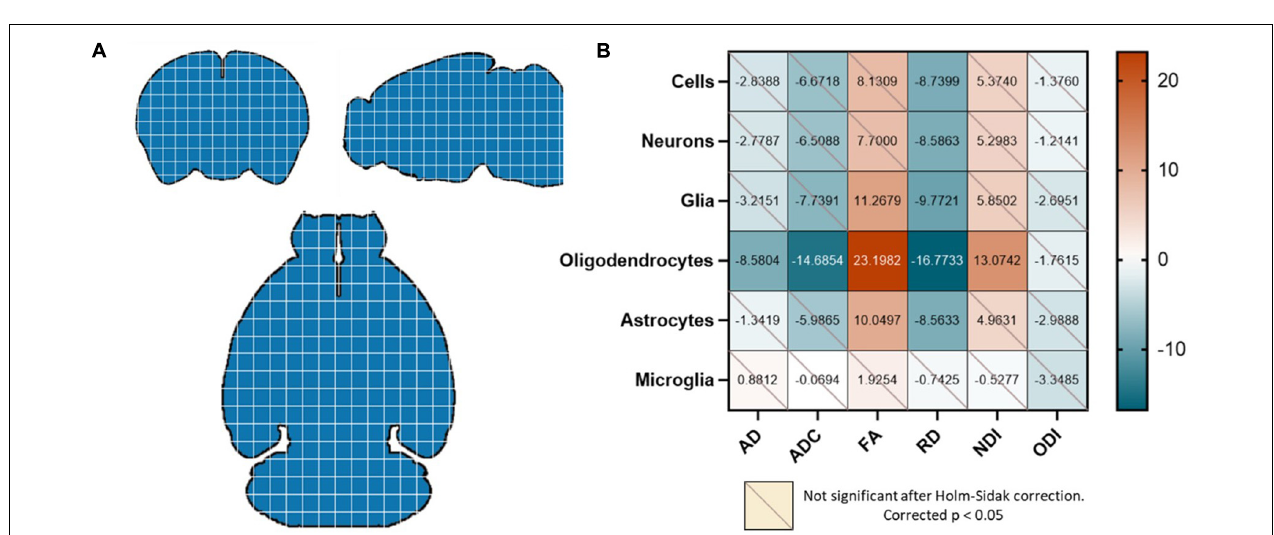
FIGURE 1 | Overview of pipeline.